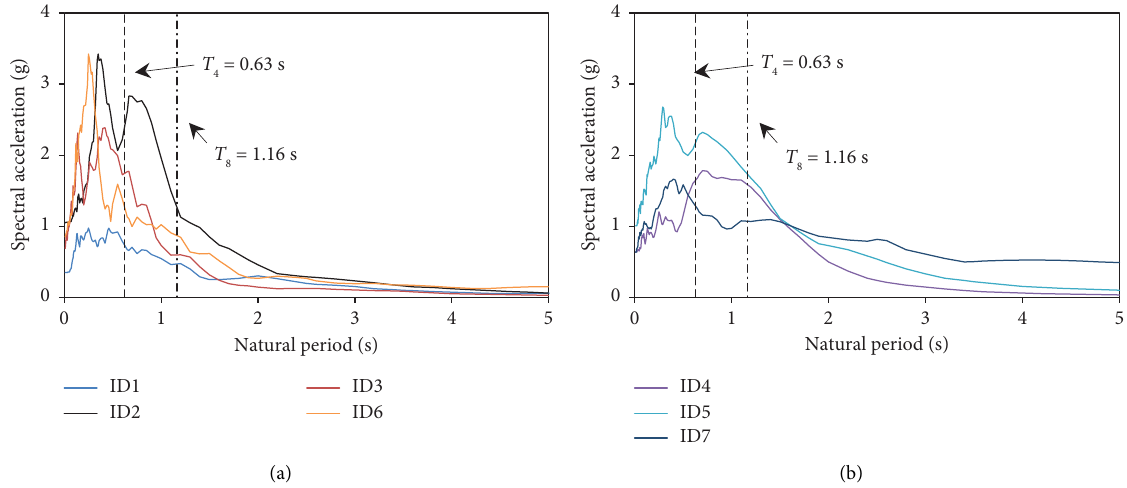
Figure 11: Response acceleration spectra of base input motions. (a) Earthquake motions in the medium-frequency range. (b) Earthquake motions in the low-frequency